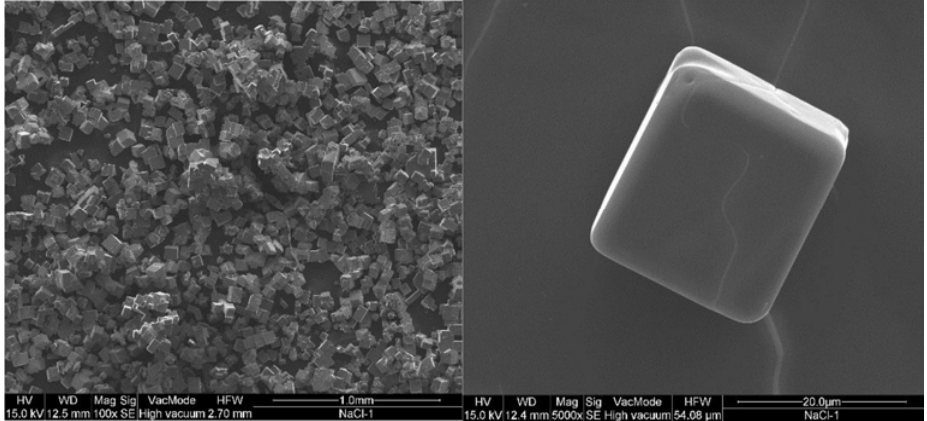
Figure 5. SEM images of the crystals precipitated from produced water ( a ) Area of crystal